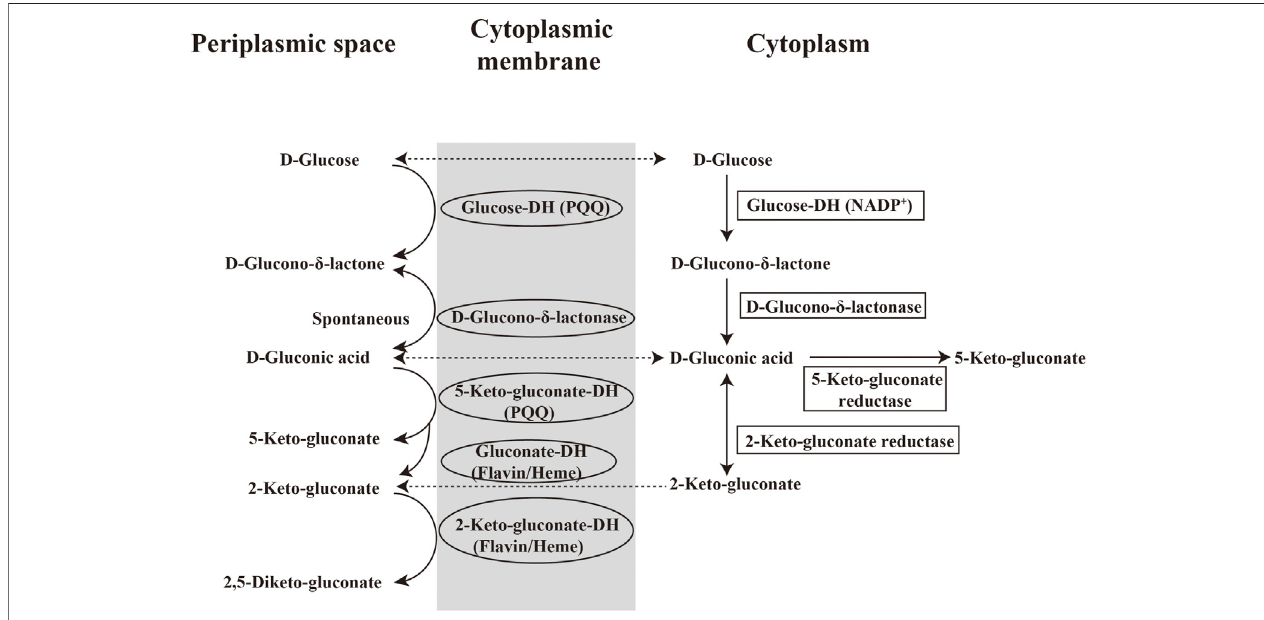
FIGURE 3 | Pathway of GA from glucose in